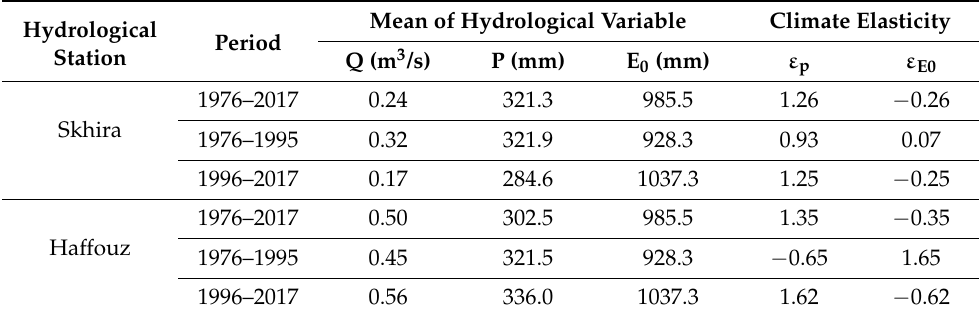
Table 5. Annual average hydrological variables and climate elasticity for the different periods of the Merguellil watershed. Mean of Hydrological Variable Climate Elasticity Hydrological Period Station